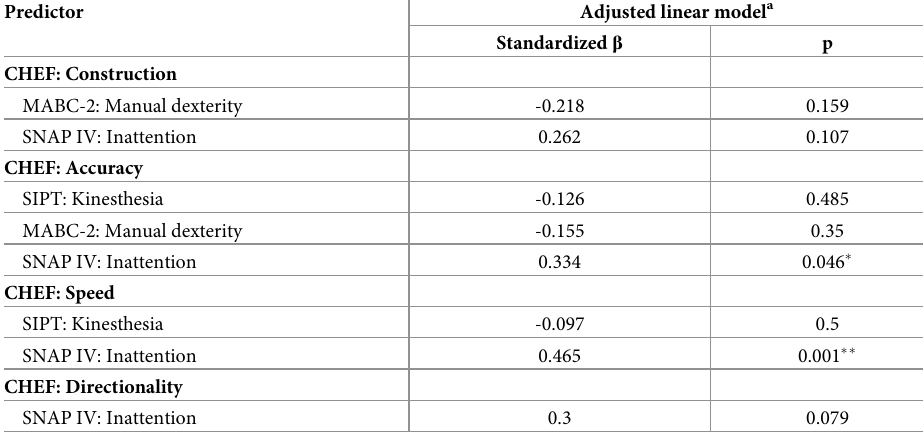
Table 5. Predictors of handwriting performance in preterm subgroup (n = 39).